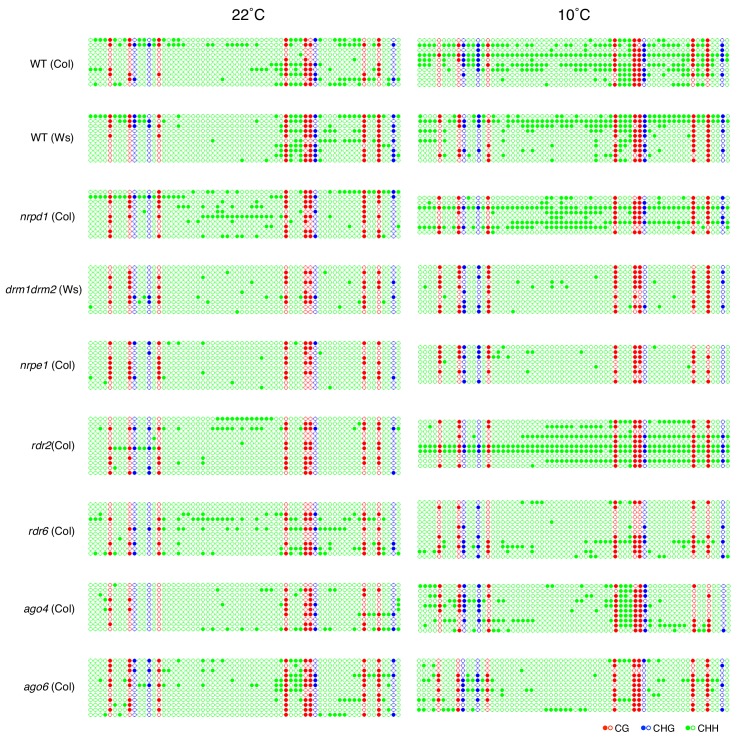
DNA methylation in the POGO region.The region analyzed for DNA methylation is indicated in Figure 2B. DNA was extracted from endosperm of mature seeds produced at 22 ˚C or 10 ˚C was analyzed by sodium bisulfite sequencing.